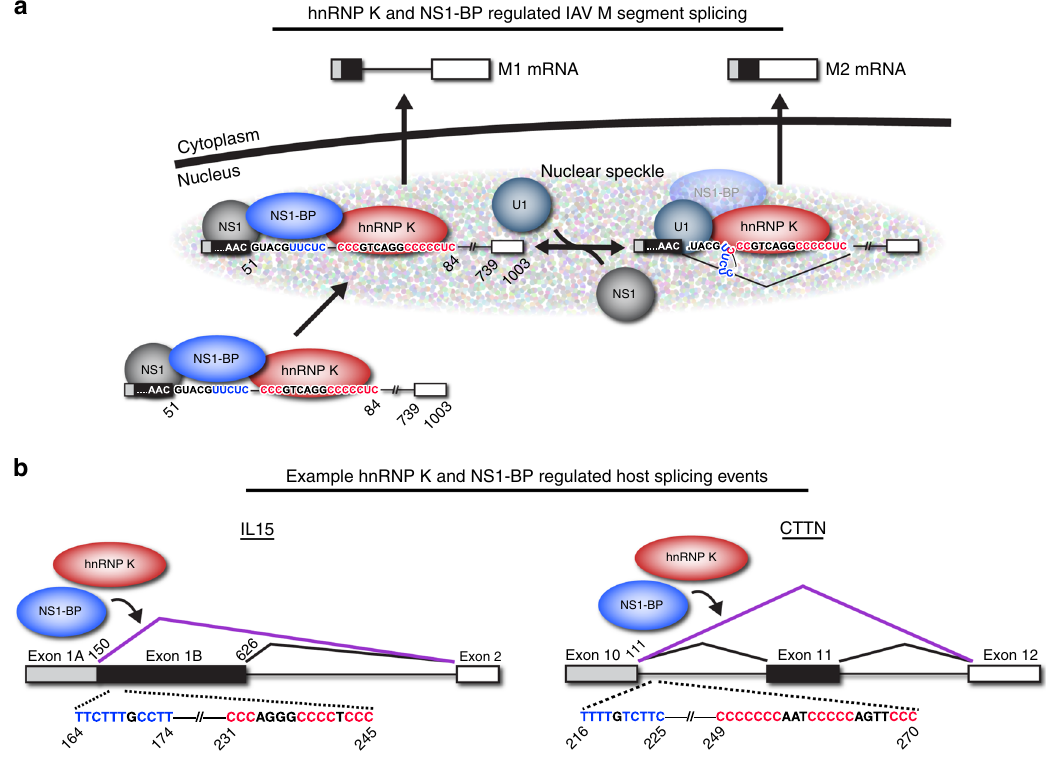
Fig. 7 Viral and host models for hnRNP K- and NS1-BP-regulated splicing. a Model of hnRNP K and NS1-BP splicing regulation of in fl uenza M segment splicing (as described in text). b Putative model of hnRNP K and NS1-BP regulated splicing of host